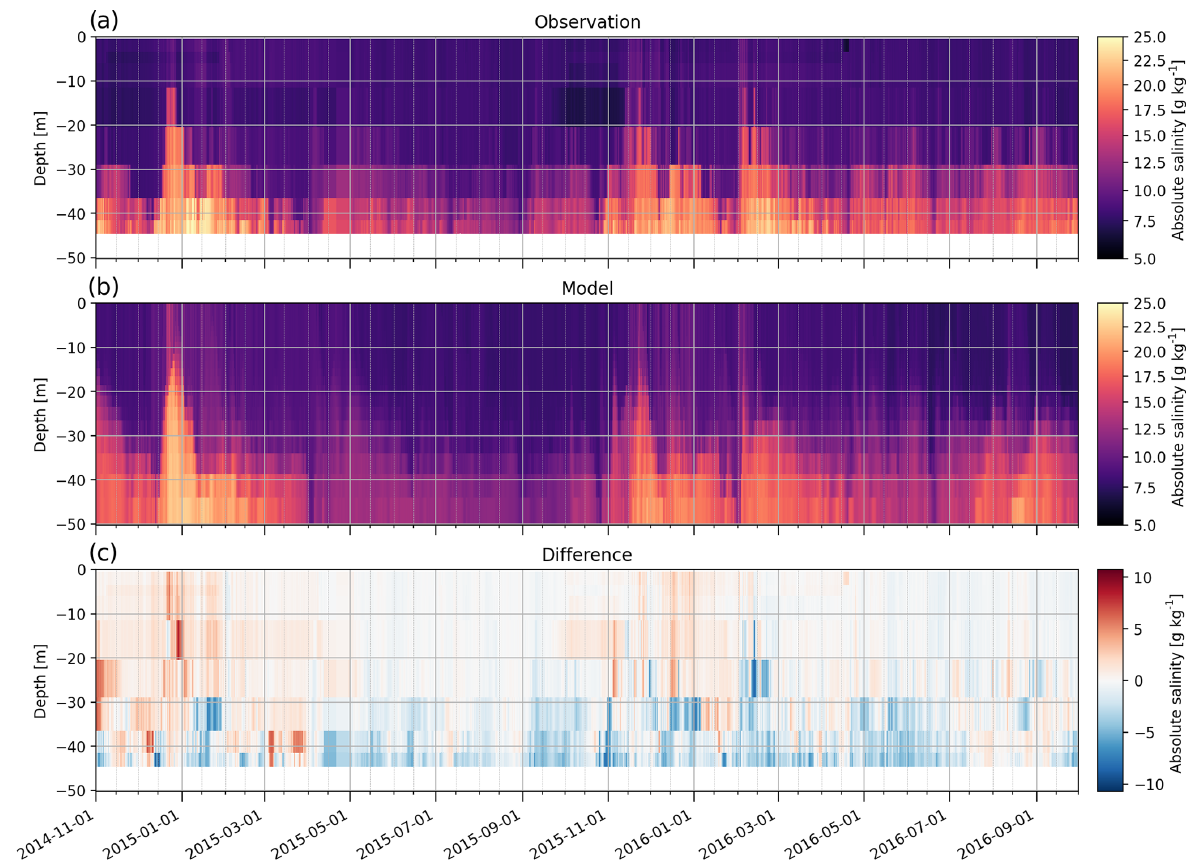
Figure 9. Vertical profile of salinity at Arkona. (a) Observations; (b) model; (c) difference (model minus observations). The difference field has been computed by interpolating the model data to the observation